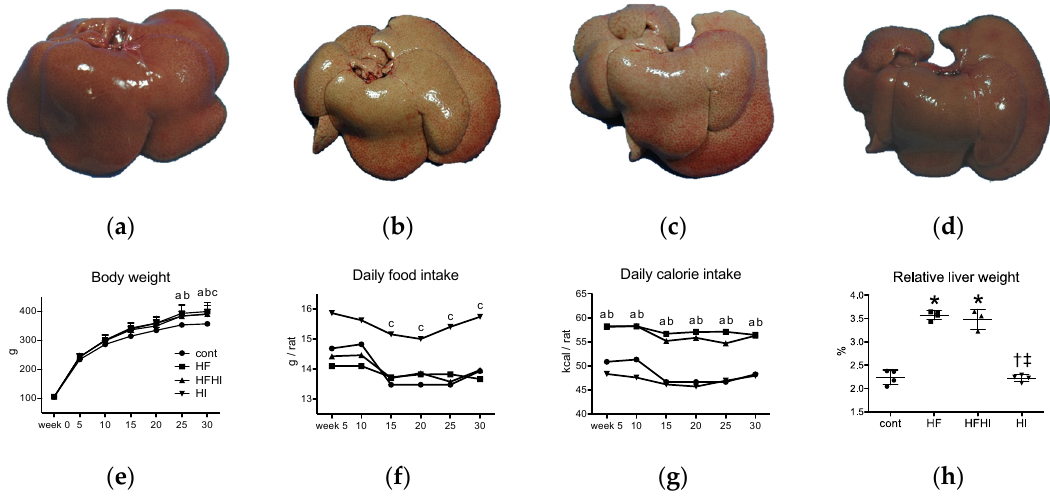
Figure 1. Gross images of the liver of ( a ) cont; ( b ) high ‐ fat (HF); ( c ) high ‐ fat and high ‐ iron (HFHI) and ( d ) high ‐ iron (HI) group at week 30. Temporal changes of ( e ) body weight; ( f ) daily food intake and ( g ) daily calorie intake ( n = 4 or 3 in each group). a p < 0.05, HF vs. cont, b HFHI vs. cont, c HI vs. cont, by Bonferroni’s multiple comparison. ( h ) Liver relative weight data at week 30. * p < 0.05 vs. control, † vs. HF, ‡ vs. HFHI, by Tukey-Kramer’s multiple